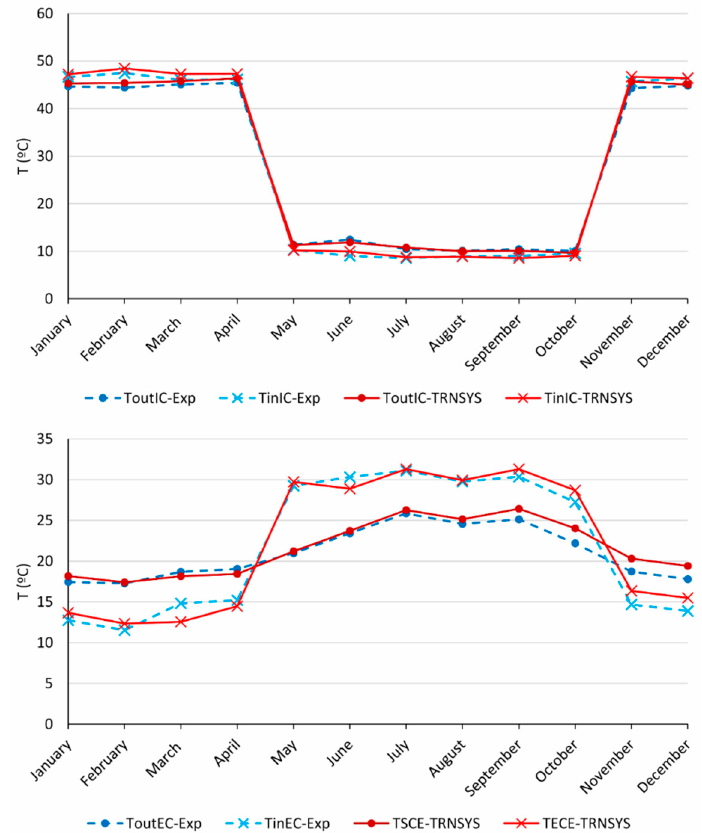
Figure 12. Average water temperature simulation results.